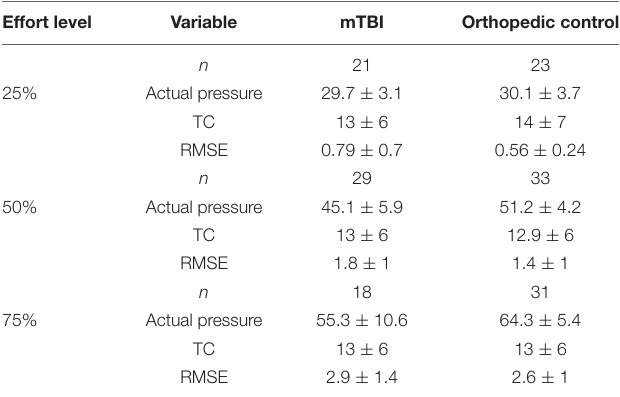
TABLE 3 | Constant effort task